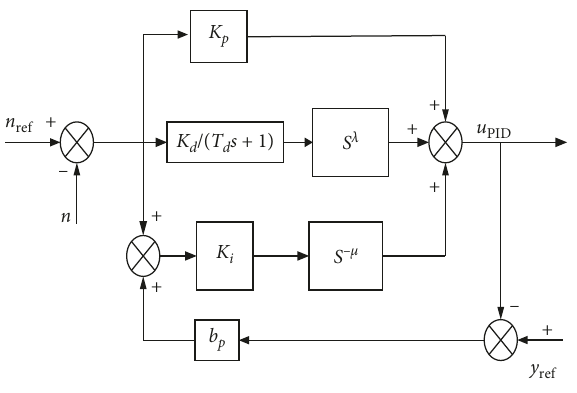
Figure 7: The parallel FOPID controller.